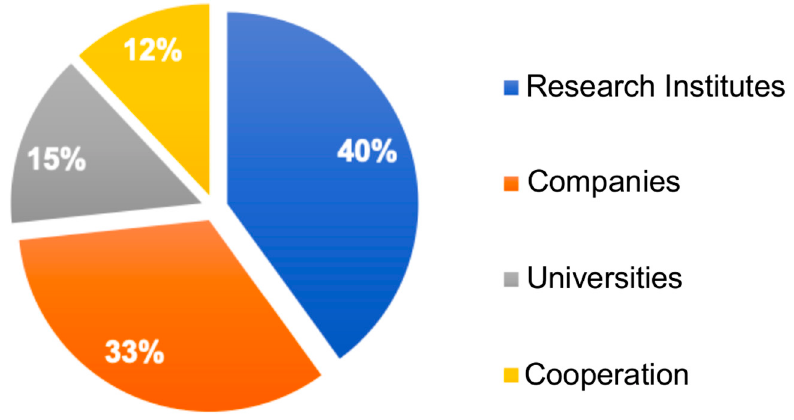
Figure 10. Number of documents by institutions.